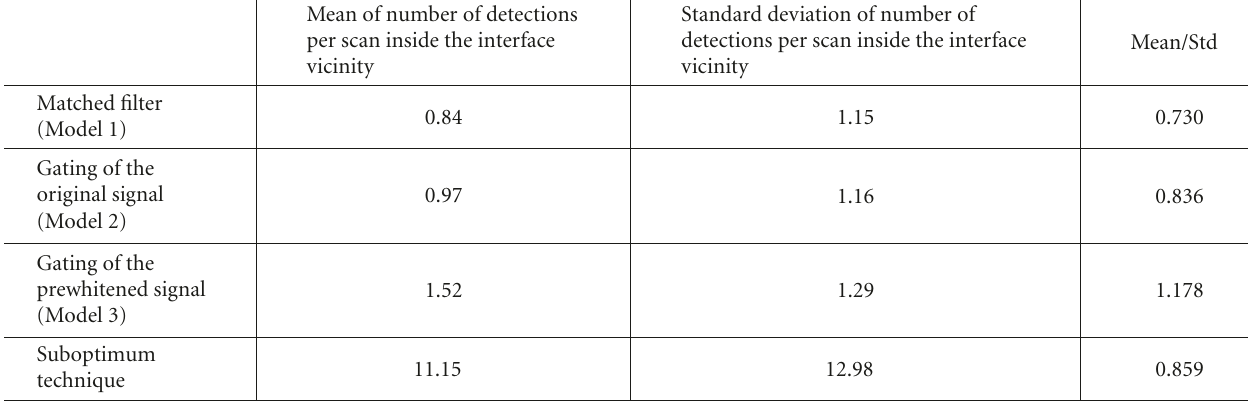
Table 1: Quantitative comparison of the results obtained with the di ff erent methods (interface vicinity is defined after Figure 6 as the delay interval from 10 to 12.5